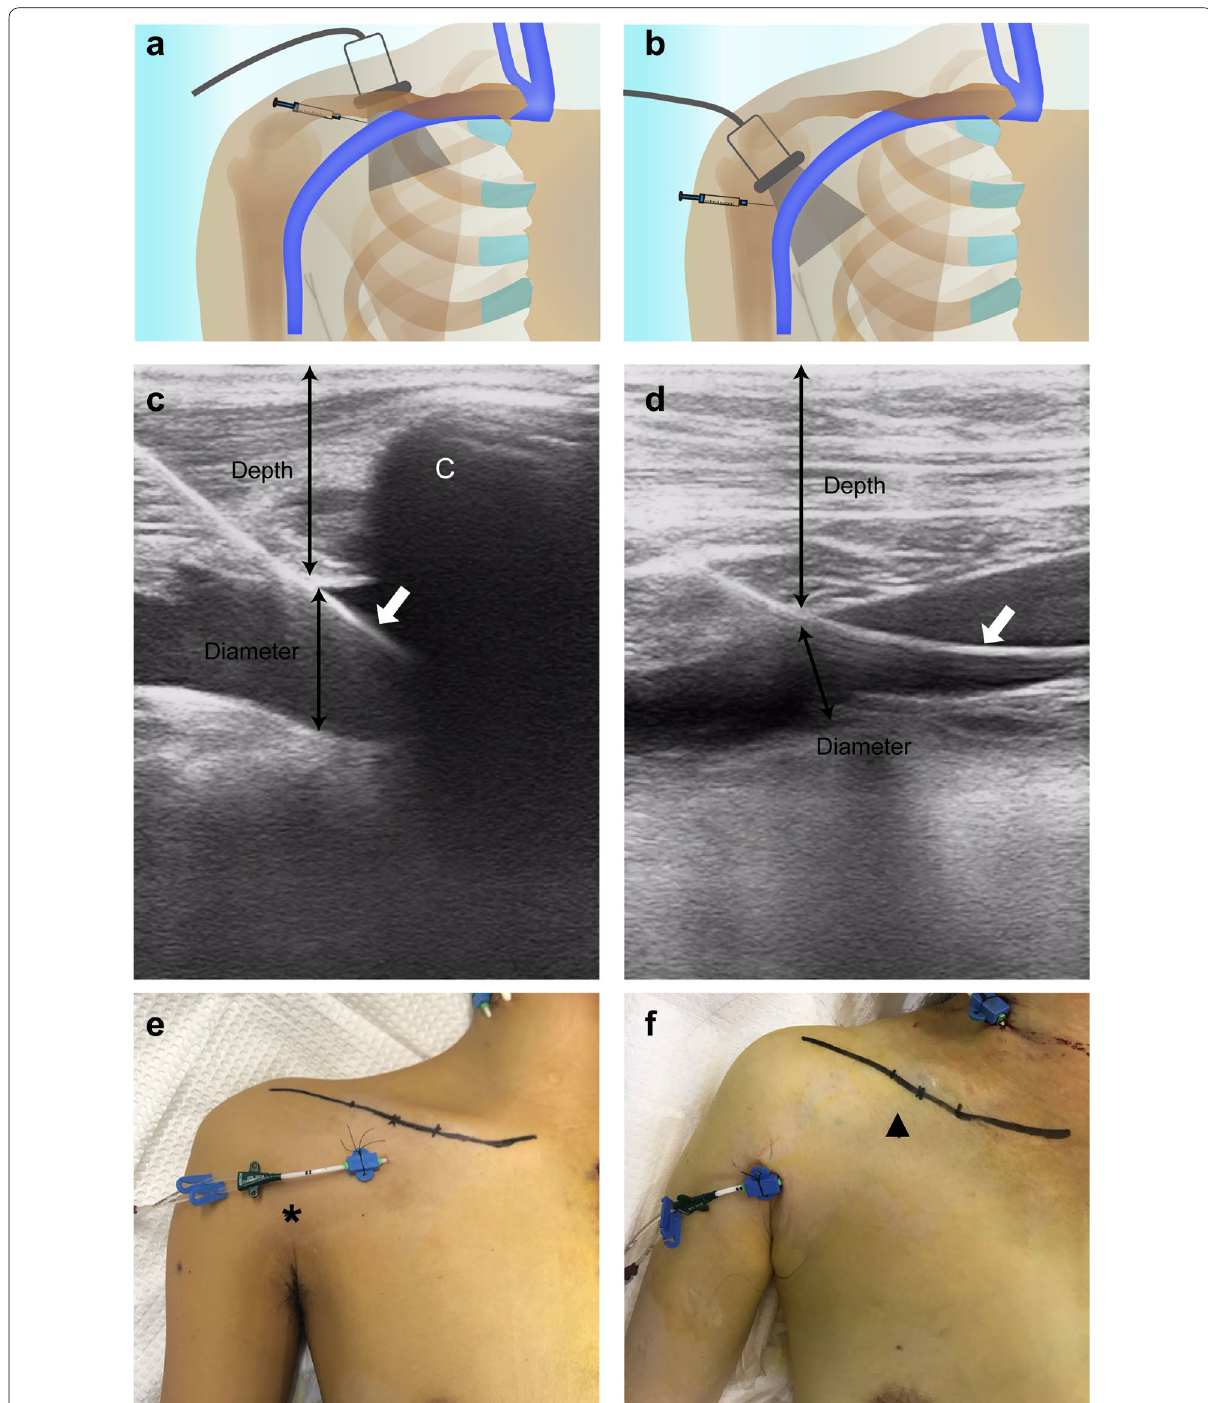
Fig. 1 Illustration of proximal axillary (left) and distal axillary (right) approaches. a , b Diagrammatic drawings of the anatomical views of proximal ( a ) and distal ( b ) approaches for ultrasound‑guided axillary venous catheterization. c , d Ultrasound visualization of the guide wire in the proximal ( c ) and distal ( d ) axillary veins. e , f catheter in place secured to the skin in proximal ( e ) and distal ( f ) approaches. The inferior margins of the clavicle are drawn in e and f , where the mid‑clavicular point and the medial and lateral one‑third of the clavicle are marked. White arrows show the guide wire. Black asterisk indicates the anticipated skin puncture site of the distal approach and black triangle indicates the anticipated skin puncture site of the proximal approach. C, clavicle; depth, the distance between skin surface and the anterior wall of vein; diameter, anteroposterior diameter of the